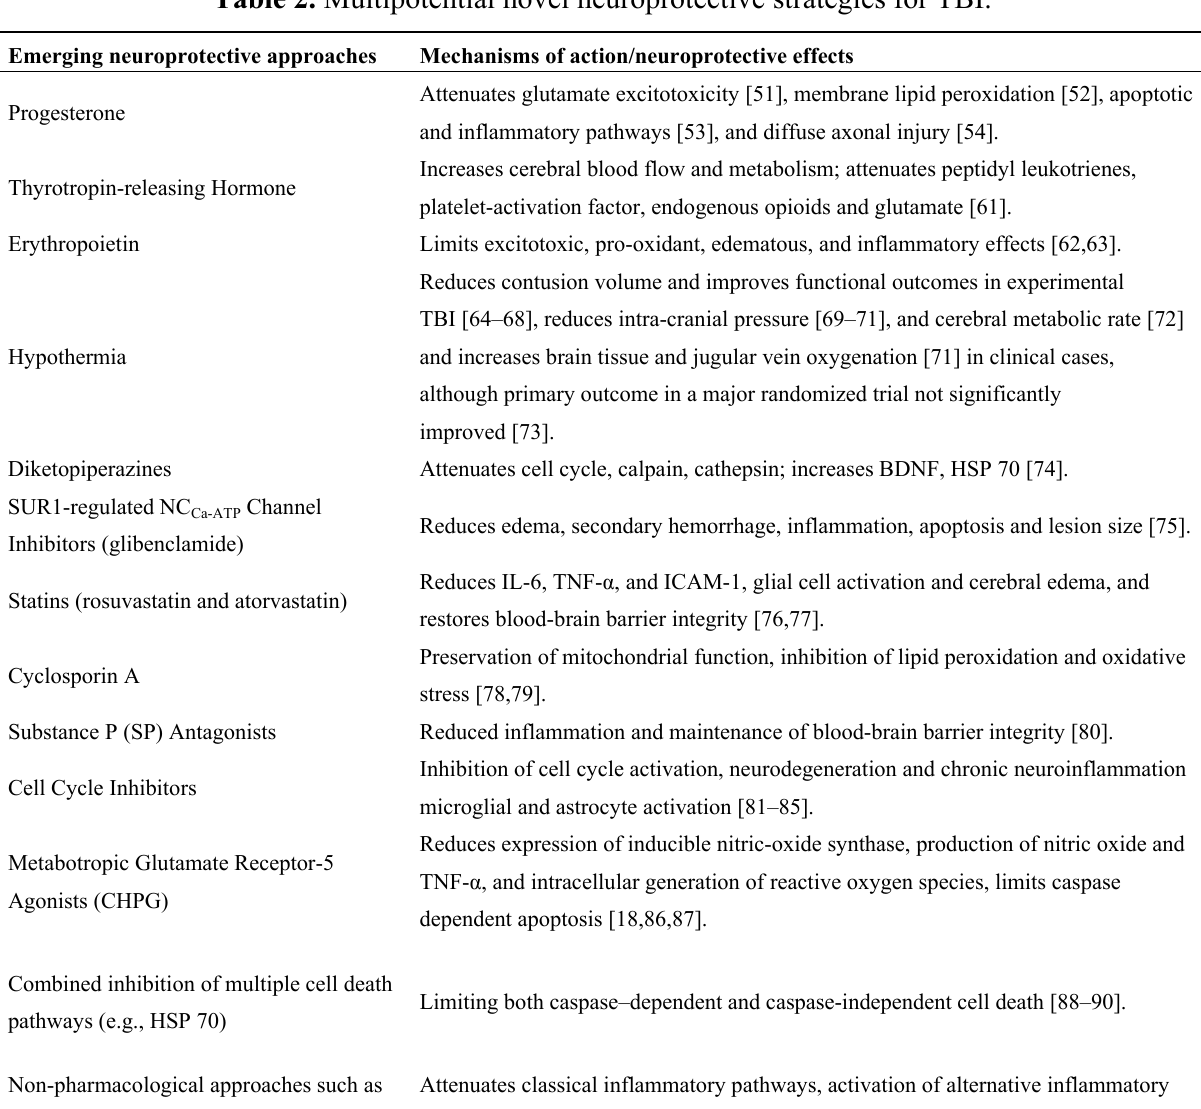
Table 2. Multipotential novel neuroprotective strategies for